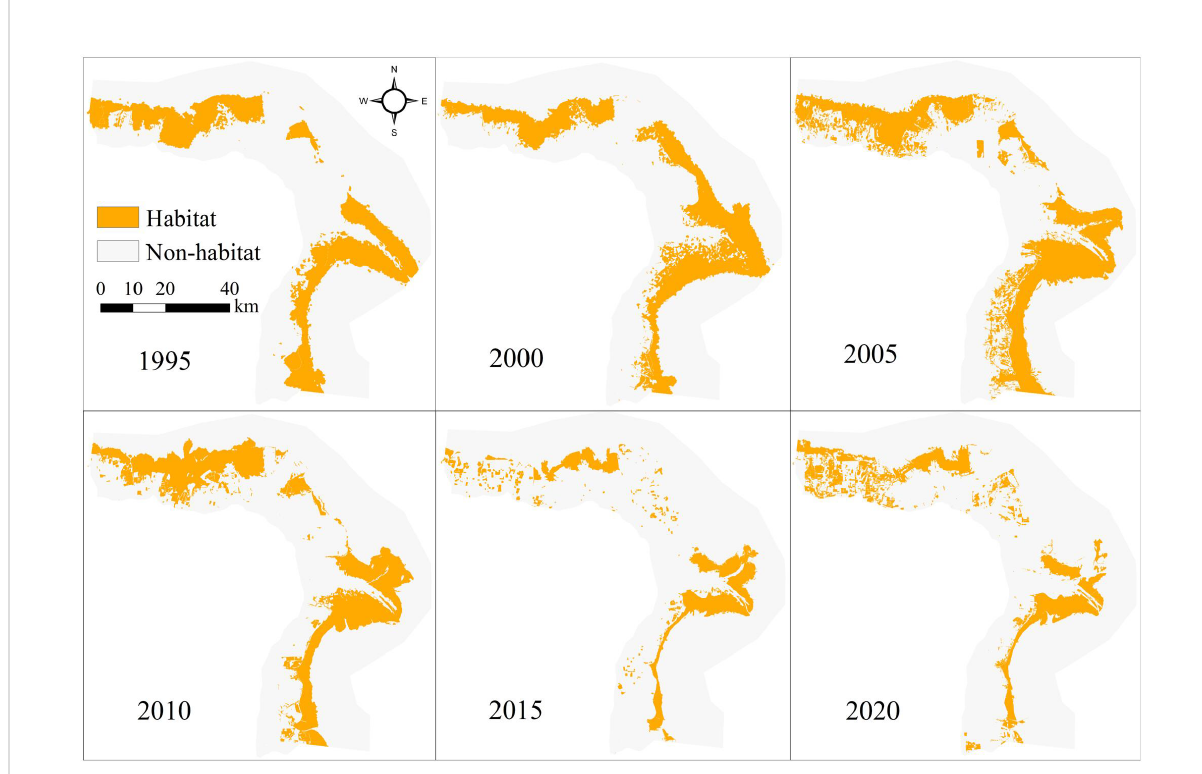
FIGURE 2 The distribution of shorebird habitat in the Yellow River Delta between 1995 and 2020 according to the InVEST